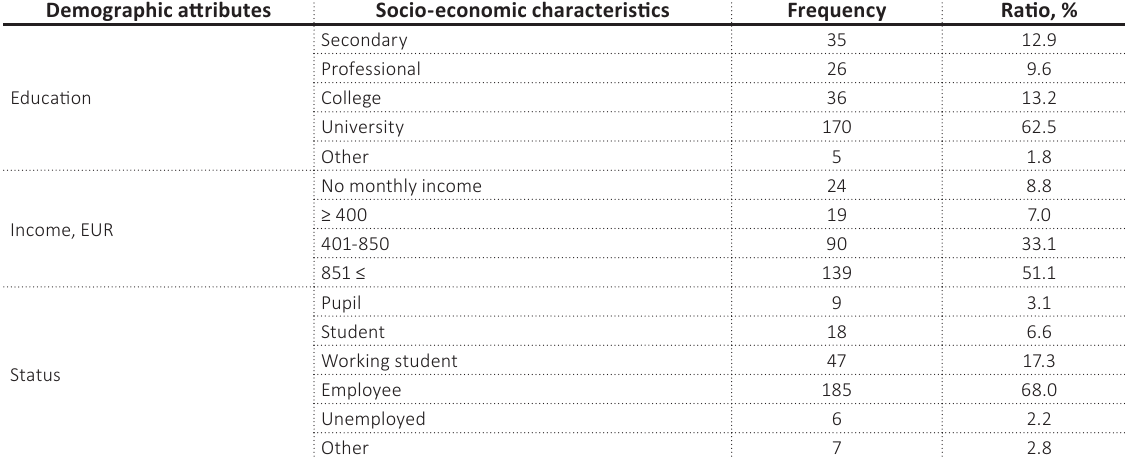
Source: Created by the